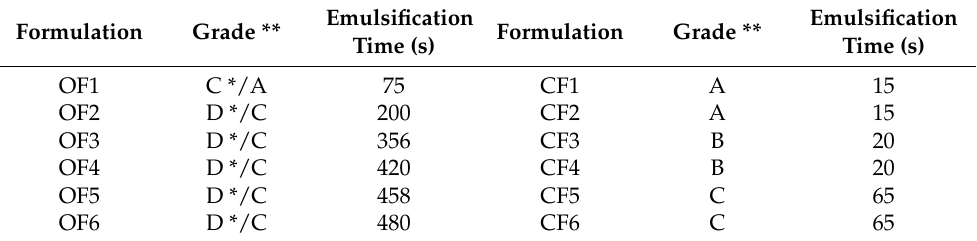
Table 3. Emulsification study observation of formulations OF1–OF6 and CF1–CF6 (grade and emulsification time).